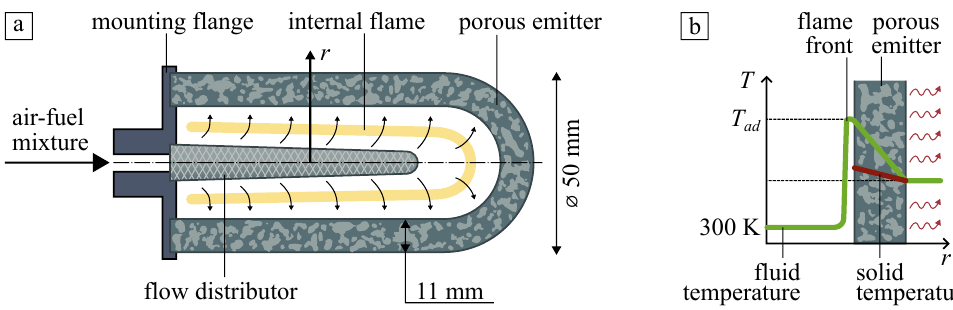
Figure 1. ( a ) Schematic diagram of thin-layered cylindrical porous burner and ( b ) typical temperature profiles along with the radius of the